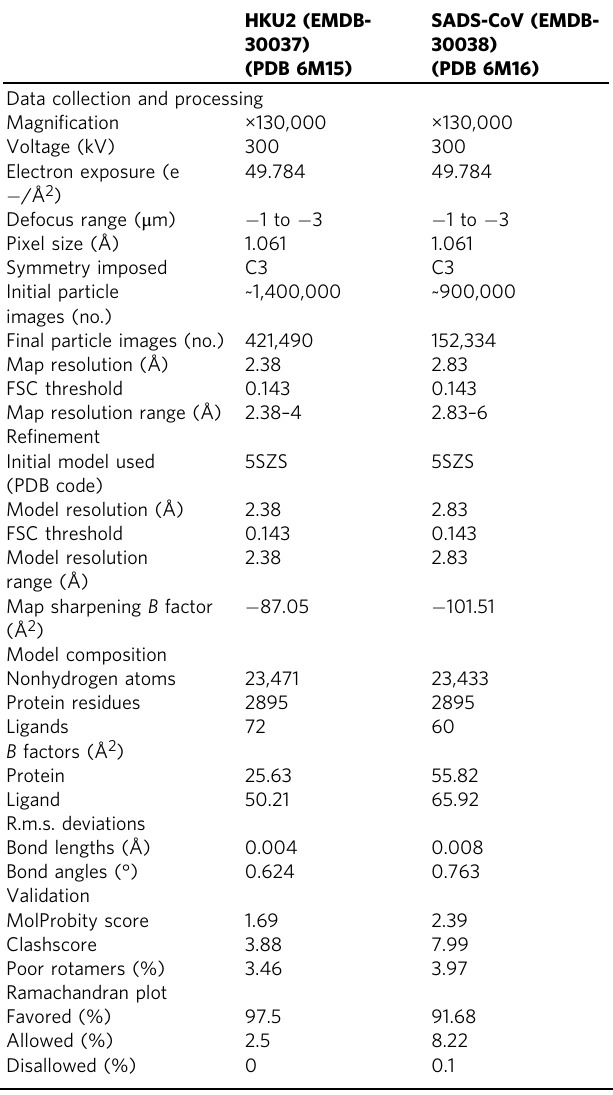
Table 1 Cryo-EM data collection, re fi nement, and validation